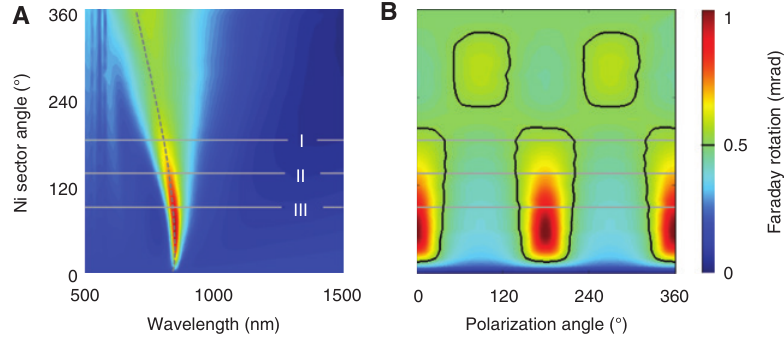
Figure 4: Bimetallic ring composition study. (A) Faraday rotation spectra calculated for different ring compositions. (B) At resonance, denoted with dashed line on (A), Faraday rotation is calculated for different polarization angles of the incident beam, and an external static magnetic field of 100 mT.